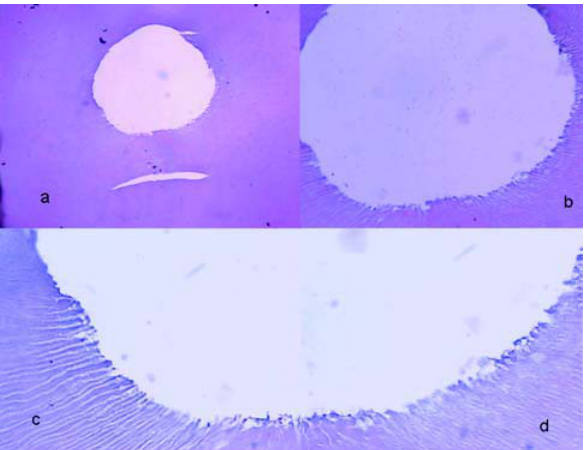
FIGURE 2- Group II- F2 instrument associated with 2.5%